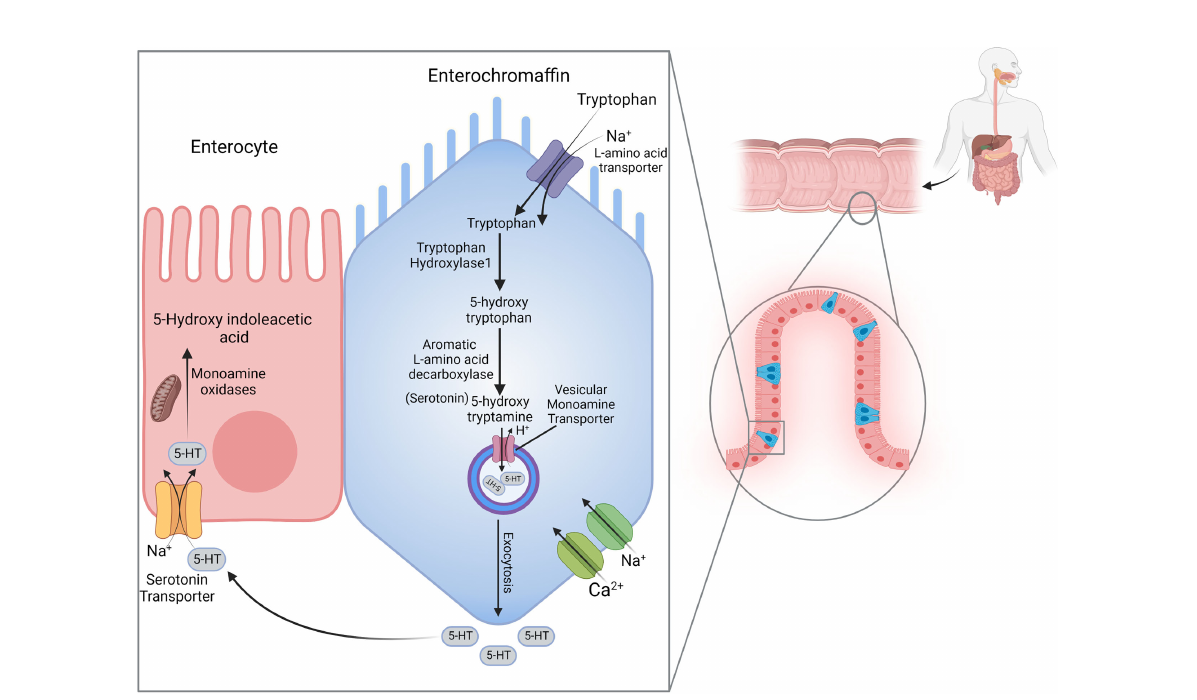
FIGURE 1 Serotonin Metabolism. Tryptophan intracellular transport is carried out by an L-amino acid transporter; then, it turns to 5-hydroxytryptophan, which is facilitated by tryptophan hydroxylase-1. In the second step, aromatic L-amino acid decarboxylase converts 5-hydroxytryptophan